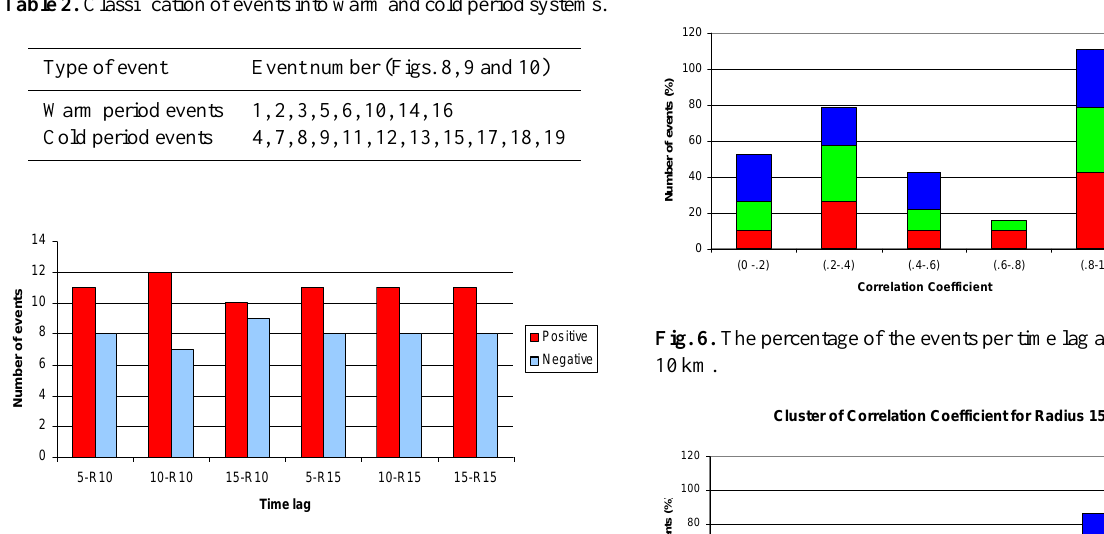
Fig. 5. The slope of the regression lines for the six schemes.